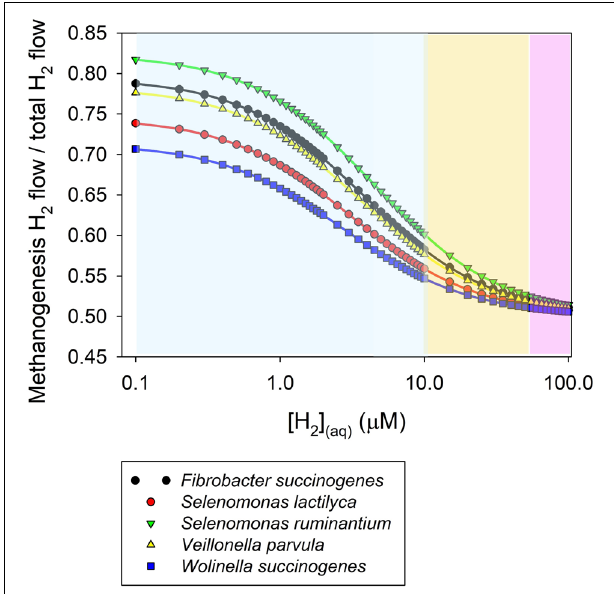
FIGURE 4 | Simulation of the proportion of dihydrogen taken up by methanogens in co-culture with various fumarate reducers as a function of dissolved H 2 concentration. The simulation was conducted based on a kinetic Michaelis-Menten-wise competition for dihydrogen. Apparent K m for H 2 uptake were reported by Asanuma et al. (1999). An equal V max for dihydrogen uptake is assumed. The range of dissolved H 2 concentration is based on Table 1 . The sky blue area corresponds approximately to baseline dissolved H 2 concentrations (i.e., in between meals). The salmon area corresponds approximately to H 2 concentration peaks occurring closely after feeding. The purple area corresponds approximately to the range of H 2 concentration that could be observed when methanogenesis is